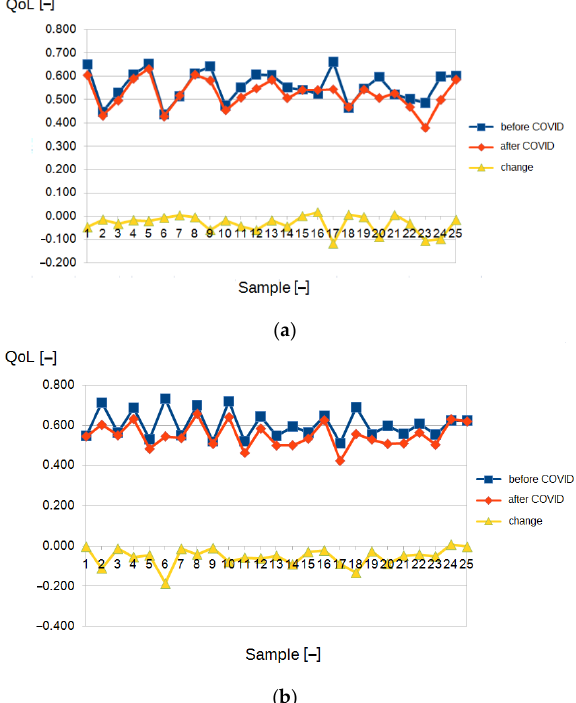
Figure 3. Results of fuzzy Quality of Life assessment: Model 2, ( a ) group 1, ( b ) group 2.